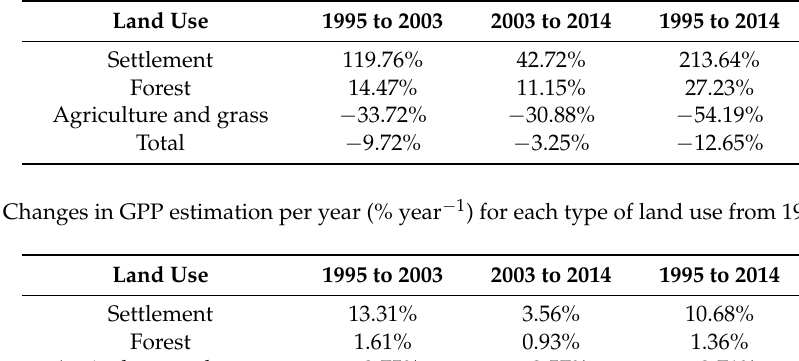
Table 6. Changes in GPP estimation per year (% year − 1 ) for each type of land use from 1995 to 2014.